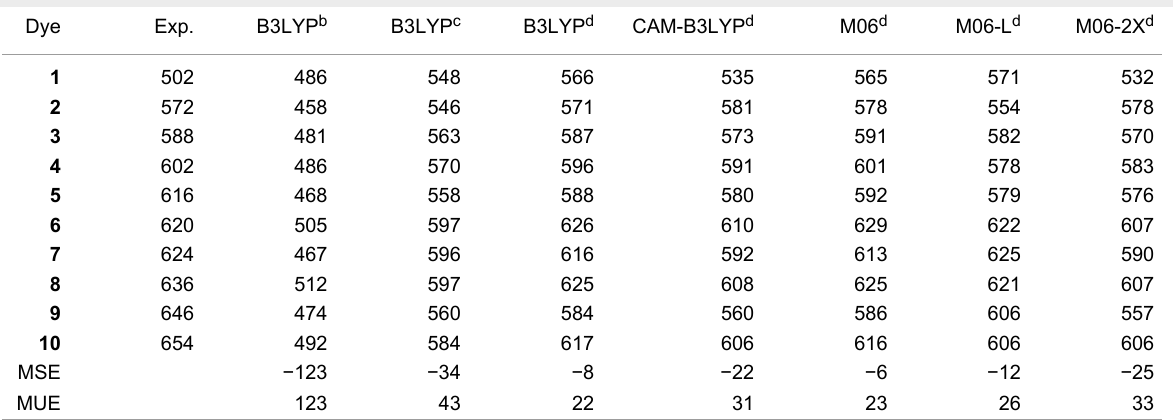
Table 3: Comparison between the experimental and calculated λ max values at different levels of theory. a